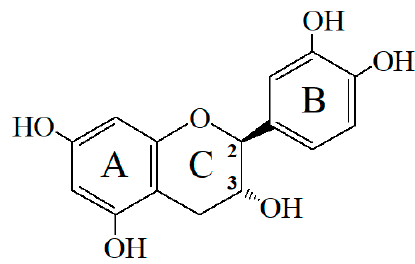
Figure 1. The structure of catechin.